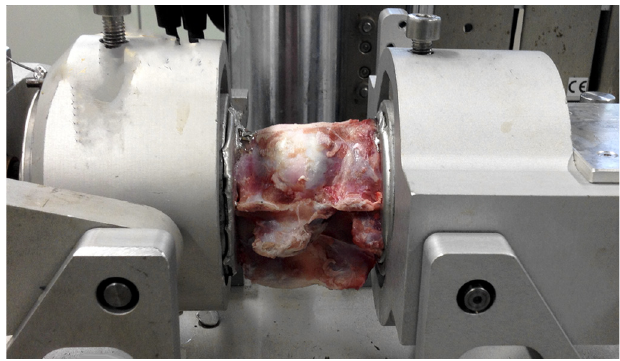
Figure 3. Test specimens were placed in a jig, seen on picture, that moves in 3 ways, fl exion – extension, lateral bending and rotation. Load was applied by a servo hydraulic machine, which recorded load and displacement. By plotting load-displacement data, a sigmoid curve is drawn from where range of motion, neutral zone and neutral zone stiffness can be calculated.